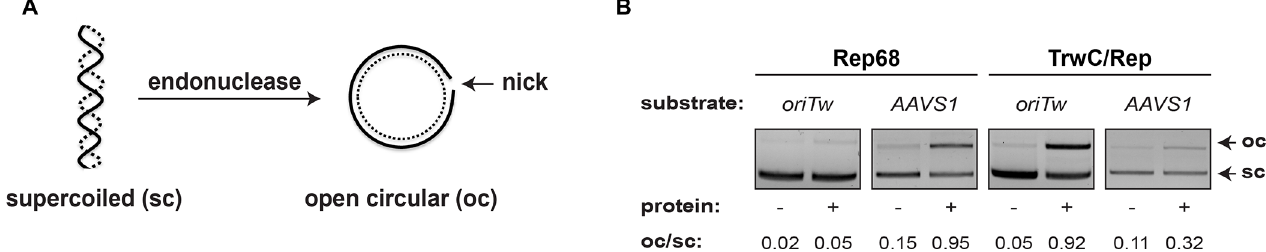
Fig 5. Rep68 and TrwC/Rep nick sc plasmid DNA containing binding and nicking sites. (A) Schematic representation of the scDNA nicking assay. When incubating a sc plasmid with an endonuclease, the protein nicks specifically inducing relaxation of the plasmid (open circular, oc), which will result in slower migrating DNA species when visualised on an agarose gel. (B) His-Rep68 and His-TrwC/Rep-mediated scDNA nicking. 100 ng of the plasmid containing the target sequence indicated on top of the gels was incubated as described in Materials and Methods with either purified His-Rep68 (left panels) or His-TrwC/Rep chimera (right panels). Products were resolved on 1% agarose gels, subsequently stained with ethidium bromide. “-“: sc plasmid incubated in the reaction buffer and processed as described above, but in the absence of protein. sc and oc products are indicated with arrows. The oc/sc ratios of quantified DNA bands are indicated at the bottom of the panels. The presented gels are representative of 3 independent experiments (n = 3).